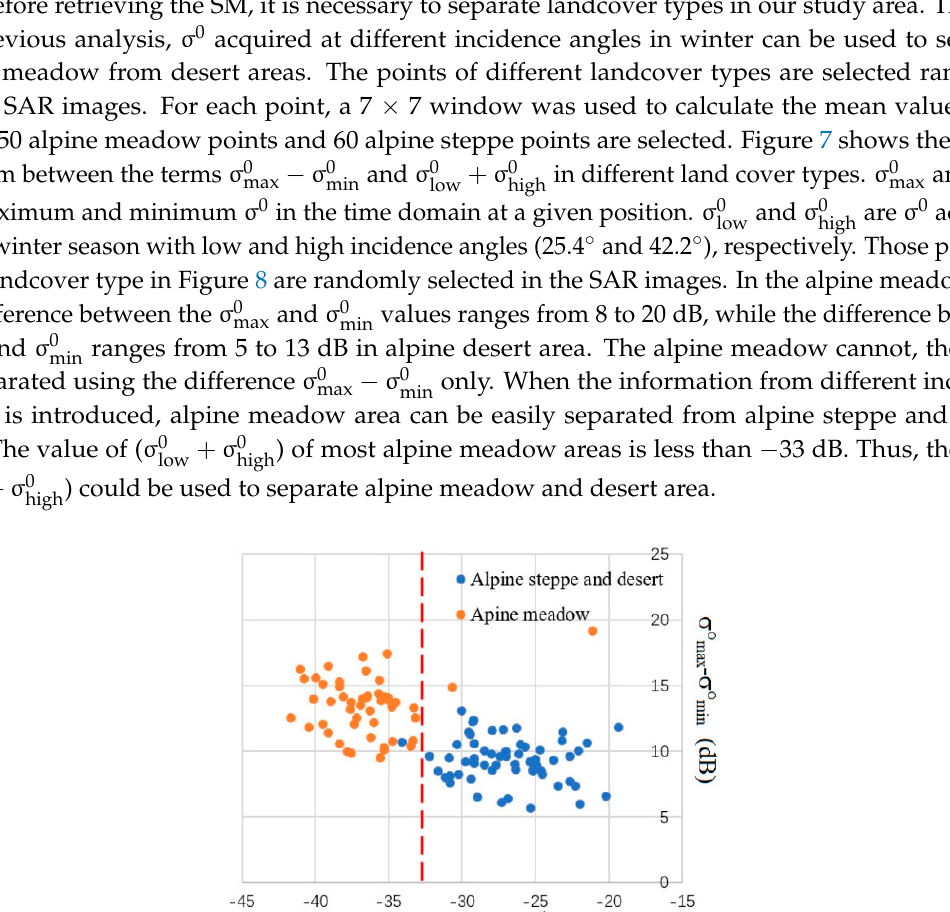
+ σ 0 ) and ( σ 0 ). Figure 7. Scatter plot between the ( σ (cid:2923)(cid:2911)(cid:2934)(cid:2868) − σ (cid:2923)(cid:2919)(cid:2924)(cid:2868) ) and ( σ (cid:2922)(cid:2925)(cid:2933)(cid:2868) + σ (cid:2918)(cid:2919)(cid:2917)(cid:2918)(cid:2868) ). min low high